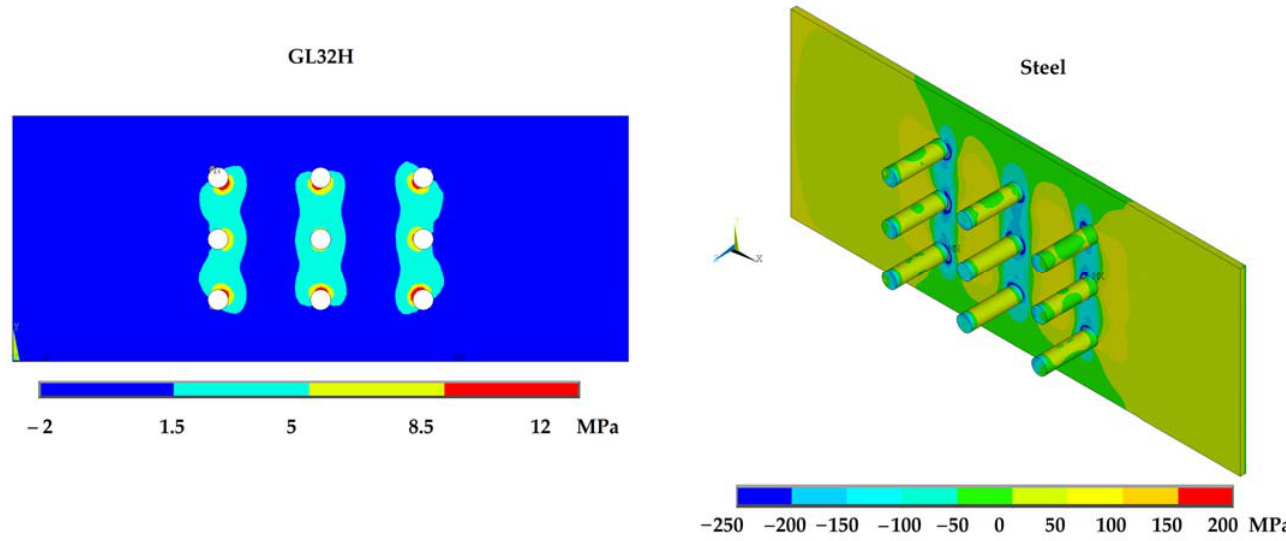
Figure 20. Normal stress of GL32H wood ( left ), steel plate, and dowels ( right ) at 300 s.